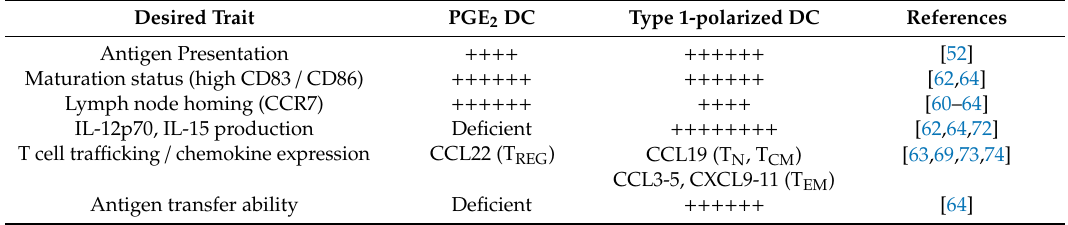
Table 1. Immunotherapeutic potential of ex vivo-educated dendritic cells (DCs). Desired